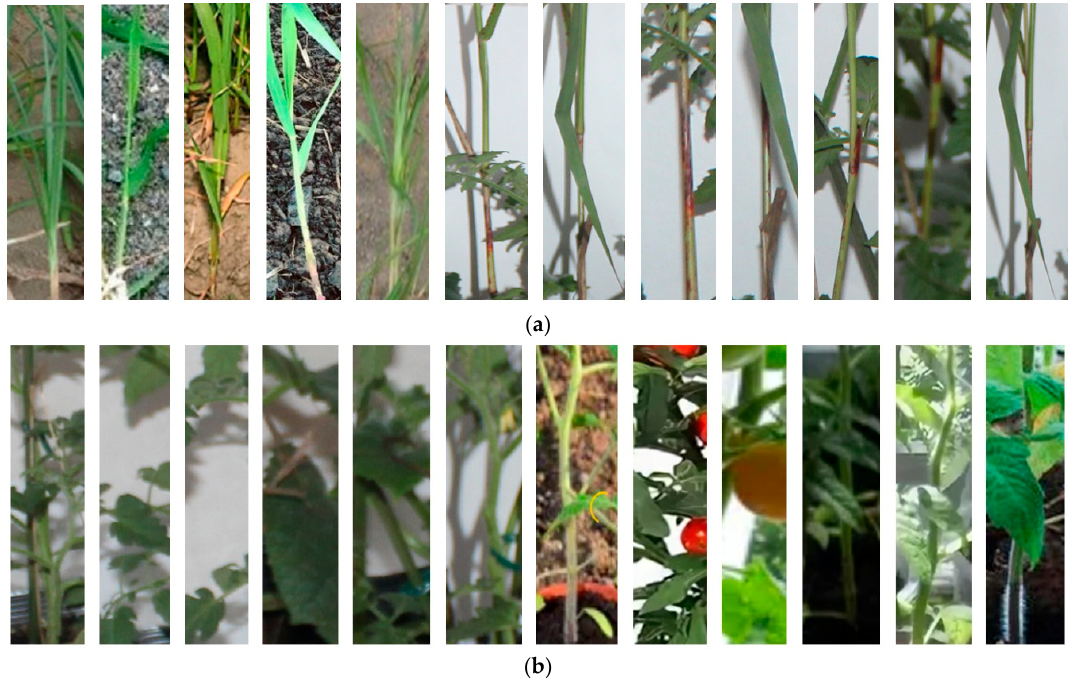
Figure 1. Images used to train Haar cascades. ( a ) Examples of images with E. repens (positive image). ( b ) Examples of images with other plants (negative images).